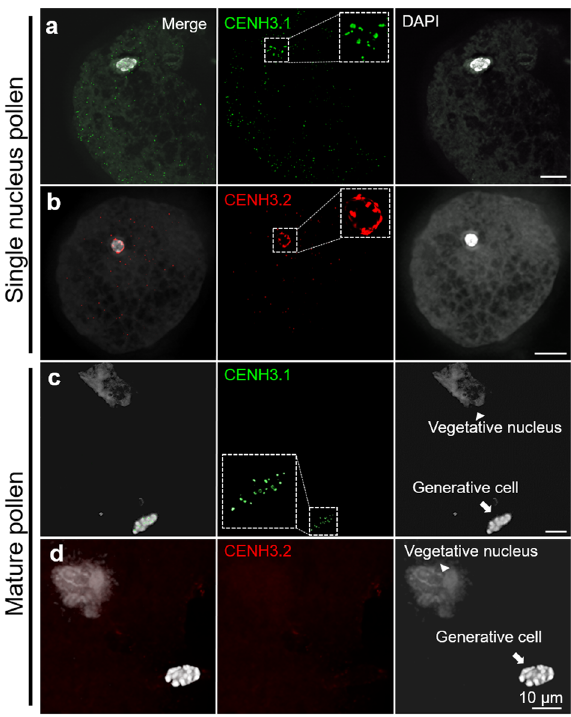
Fig. 5 The organization of cowpea centromeres during microgametogenesis. a , b CENH3.1 (green) and CENH3.2 (red) localize in the centromeres of early-stage mononucleate pollen. Further enlarged nuclei are shown as insets. c , d In mature binucleate pollen, the vegetative nucleus shows no centromeric CENH3.1 (green) and CENH3.2 (red). Centromeric CENH3.1 (green) localizes in the generative nucleus of mature pollen ( c ), while CENH3.2 (red) does not ( d ), suggesting speci fi c removal.